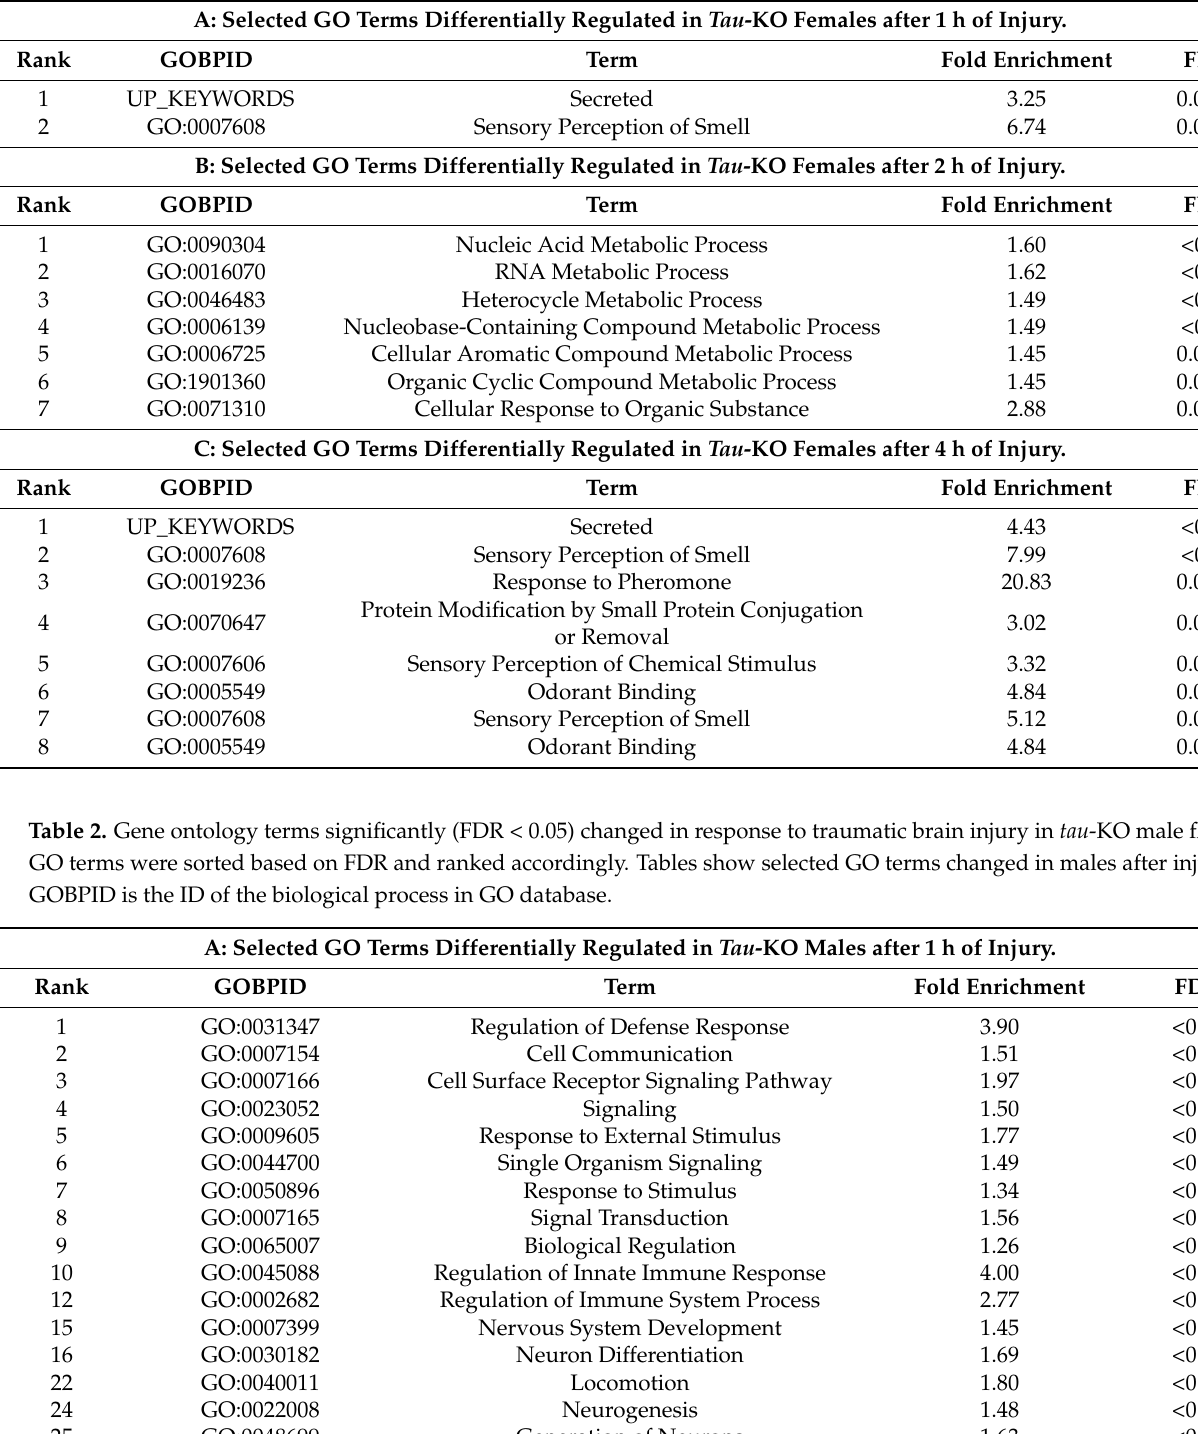
Table 1. Gene ontology terms significantly (FDR < 0.05) changed in response to traumatic brain injury in tau-KO female flies. GO terms were sorted based on FDR and ranked accordingly. Tables show selected GO terms changed in females after injury. GOBPID is the ID of the biological process in GO database.